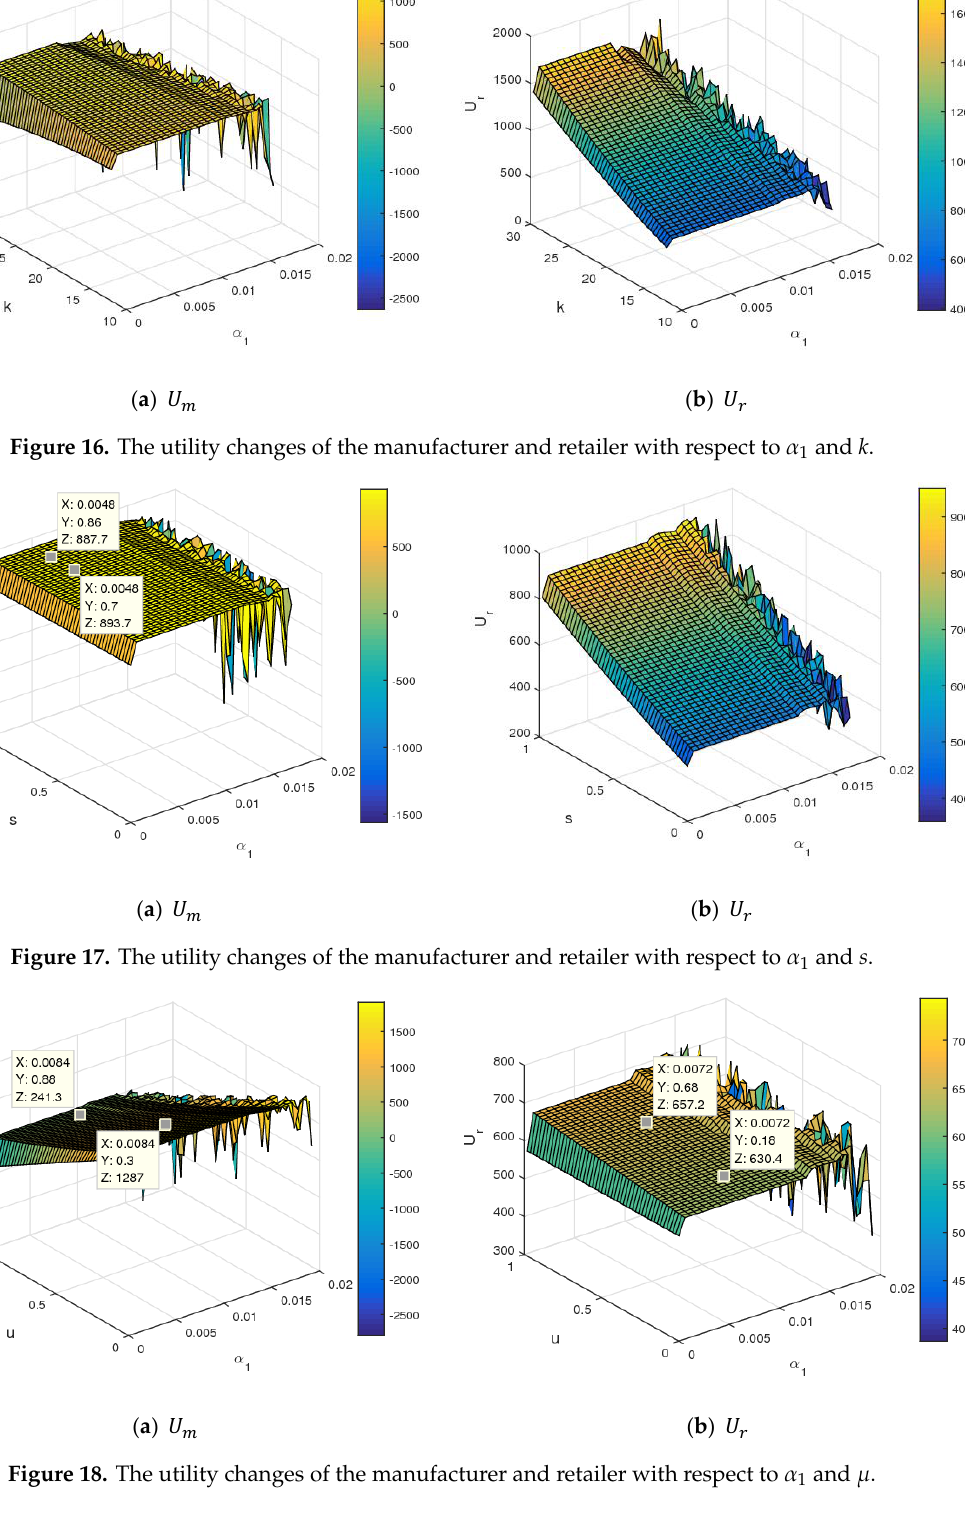
Figure 18. The utility changes of the manufacturer and retailer with respect to 𝛼 1 and 𝜇.